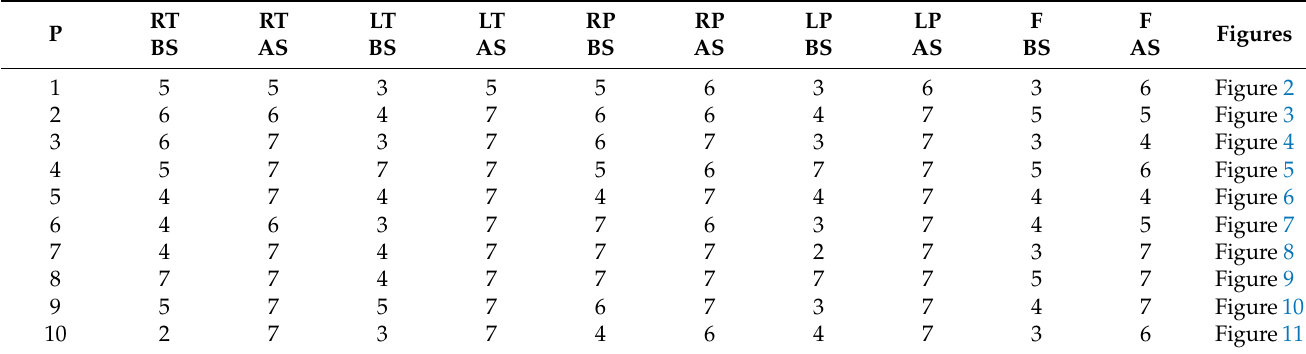
Table 2. Maximum frequency between the first MEG recording before stimulation (BS) and the MEG recording after stimulation (AS) for the affected brain regions of the AD patients.